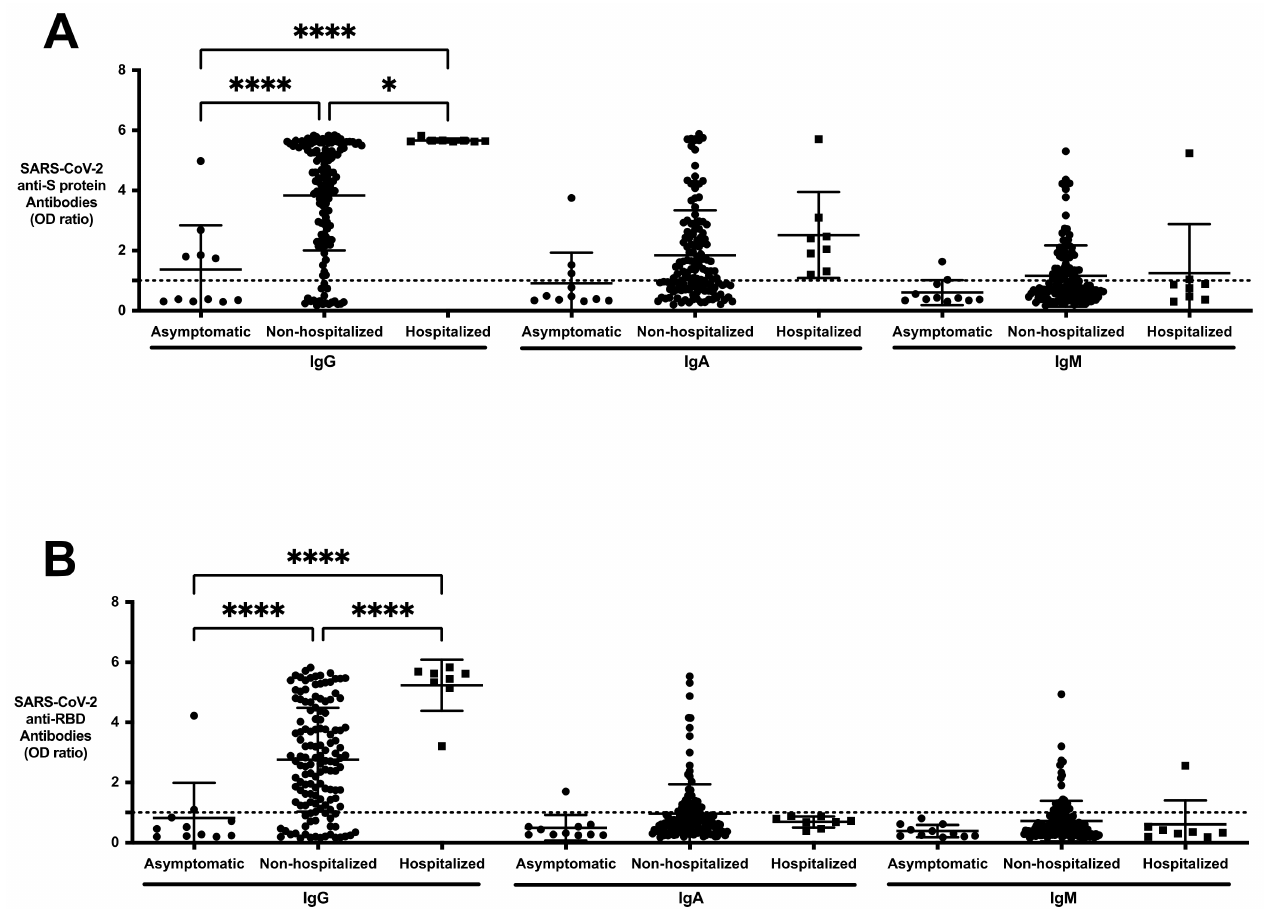
Figure 4. Comparing anti-SARS-CoV-2 IgG, IgA, and IgM responses to S protein and RBD antigens in asymptomatic, non-hospitalized, and hospitalized resolved subjects. ( A ) Anti-S protein IgG, IgA, IgM, and ( B ) anti-RBD IgG, IgA, and IgM of the asymptomatic ( n = 11), non-hospitalized resolved subjects ( n = 134) and hospitalized resolved subjects ( n = 8) were profiled using the SARS-CoV-2 ELISA. Values are shown as a ratio of observed optical density to the determined assay cut-off optical density. All hospitalized subjects had detectable anti-S protein IgG, anti-RBD IgG, and anti-S protein IgA antibodies in their serum. The levels of anti-S protein and anti-RBD IgG (mean OD 405nm ratio) in resolved subjects who were hospitalized were significantly higher than the non-hospitalized resolved population. Values above 1 ratio are considered positive in the SARS-CoV-2 ELISA. * p < 0.05, ** p < 0.01, *** p < 0.001, **** p <